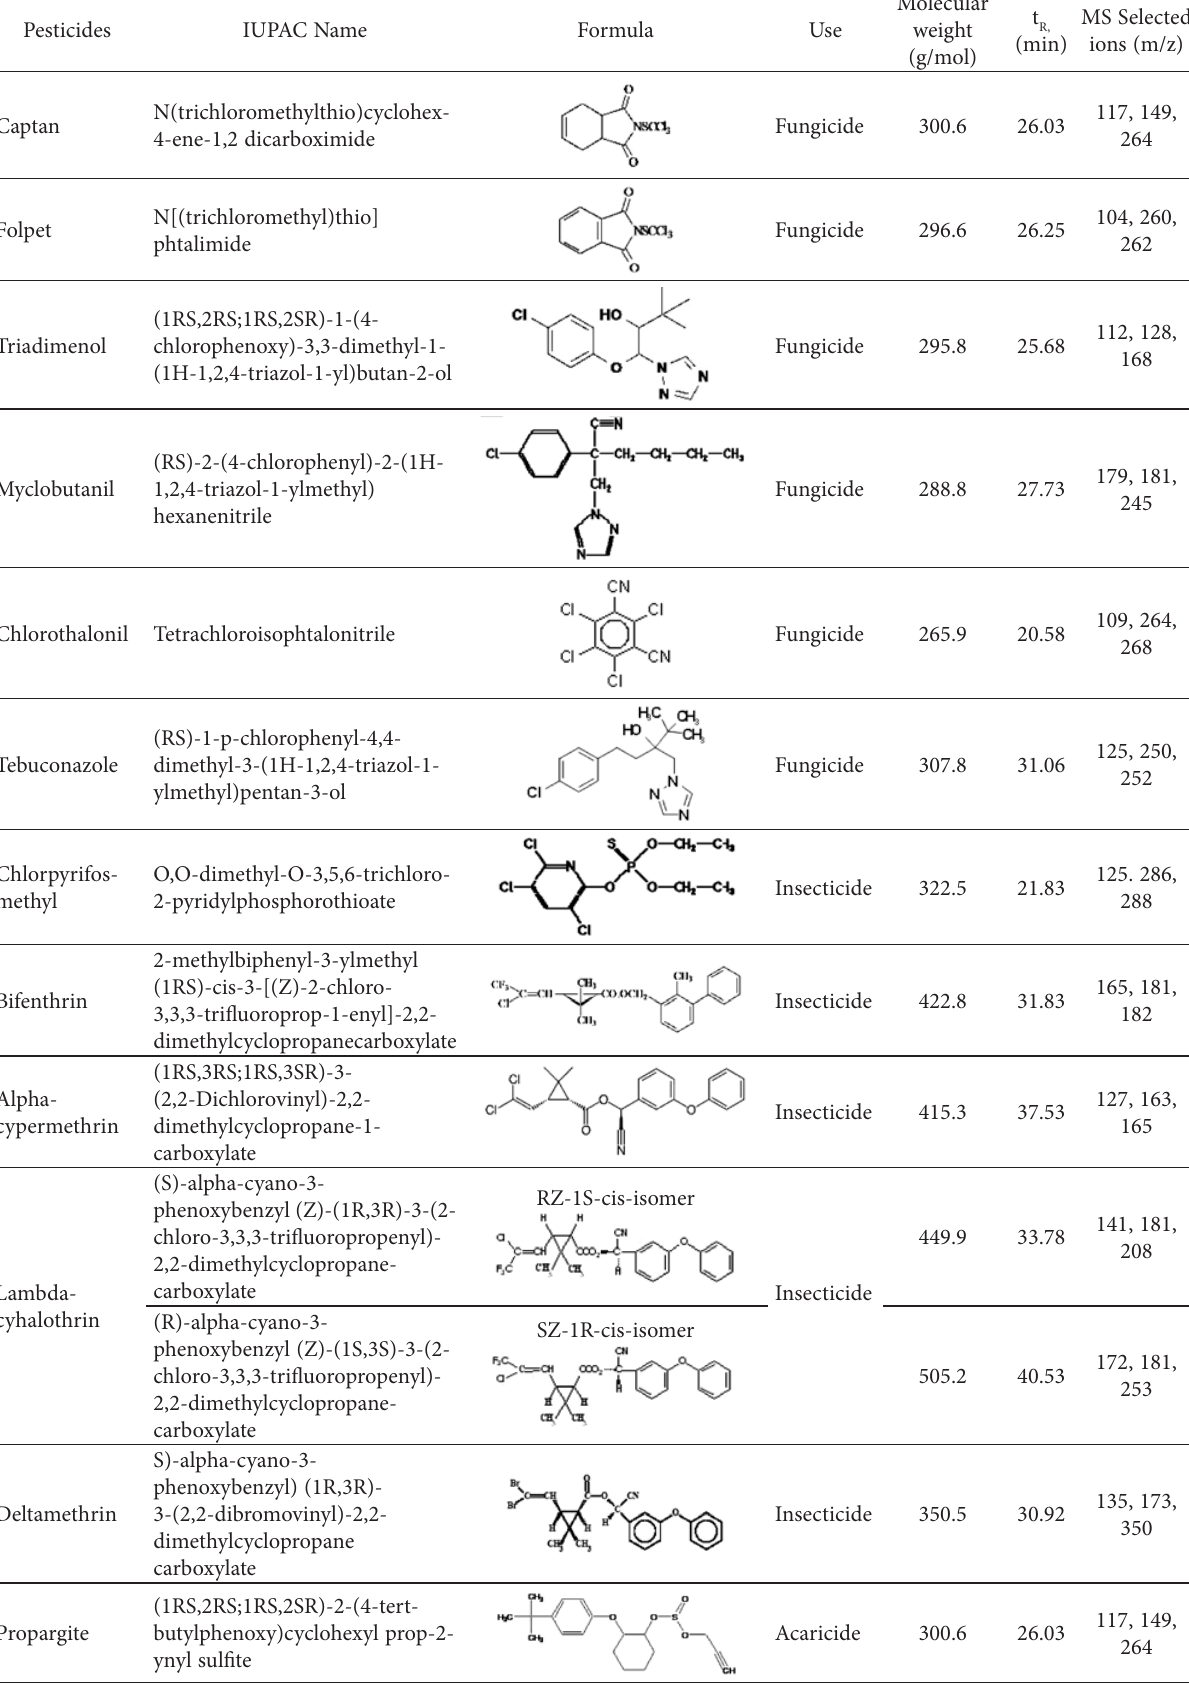
Table 2. Pesticides identification based on GCxGC-TOF MS conditions Pesticides IUPAC Name Formula